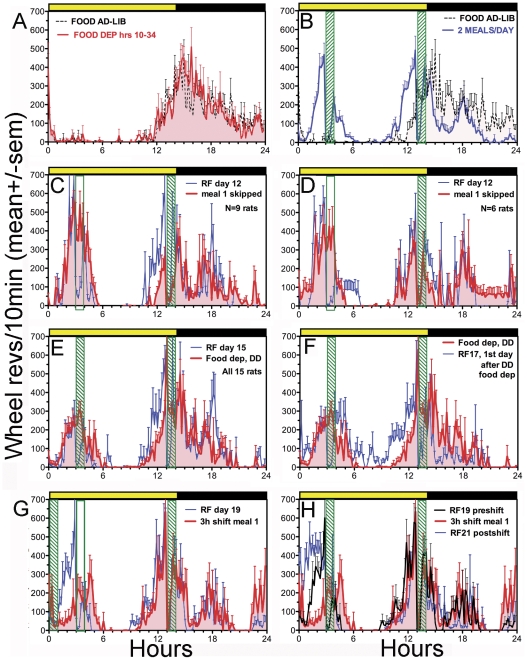
Group mean (± sem) waveforms of normalized wheel running activity in

Experiment 1

. Time is plotted in 10 min bins from lights-on (Hour 0, yellow bar). Meal times are denoted by green stripped vertical bars (hollow when meals were skipped). A. Last 4 days of ad-lib food access (dashed line) and 37-h food deprivation (red solid line, shaded) prior to initiation of 2-meal restricted feeding (RF) schedule. B. Ad-lib (dashed line) and RF days 8–12 (blue, solid line). C. RF day 12 (blue line) and Meal 1 omission day (red line, shaded), n = 9 rats showing delayed onset of anticipation to Meal 2. D. RF day 12 (blue line) and Meal 1 omission day (red line, shaded), n = 6 rats showing no change in anticipation onset. E. RF day 15 (blue line) and total food deprivation day with lights-off (DD, red line, shaded). F. Total food deprivation day in DD (red line, shaded) and first day of RF after food deprivation (blue line). G. RF day 19 (blue line) and 3-h shift of Meal 1 (red line, shaded). H. RF day 19 (black line), 3-h shift of Meal 1 (red line, shaded), and day after 3-h shift of Meal 1 (RF21, blue line).